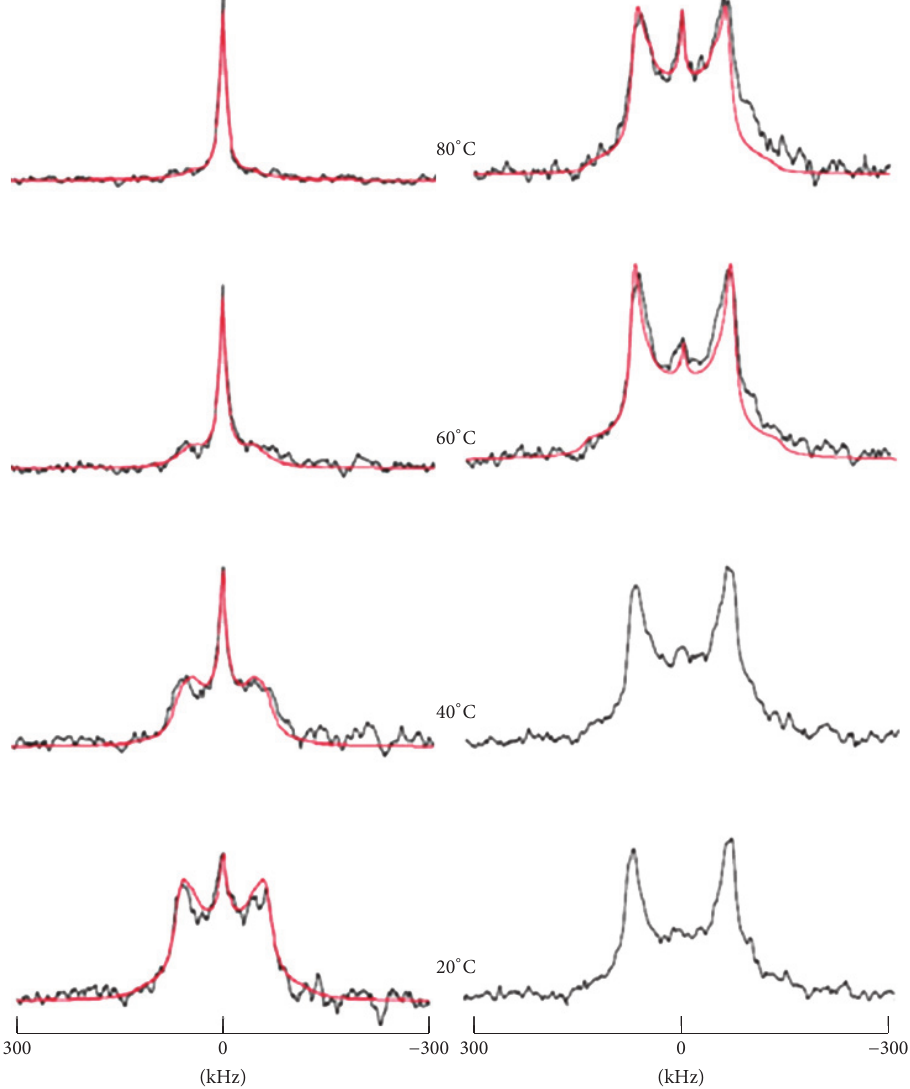
Figure 6: 2 H NMR of [Al( 𝜇 2-OH)(1,4-ndc) ] 𝑛 (1,4-ndc: 1,4-naphthalenedicarboxylate) [66] and [Al( 𝜇 2-OH)(1,4-bdc) ] 𝑛 (1,4-bdc: 1,4- benzenedicarboxylate)loadedwithimidazole-d4molecules[61].ReprintedwithpermissionfromRef.[61].Copyright2009NaturePublishing